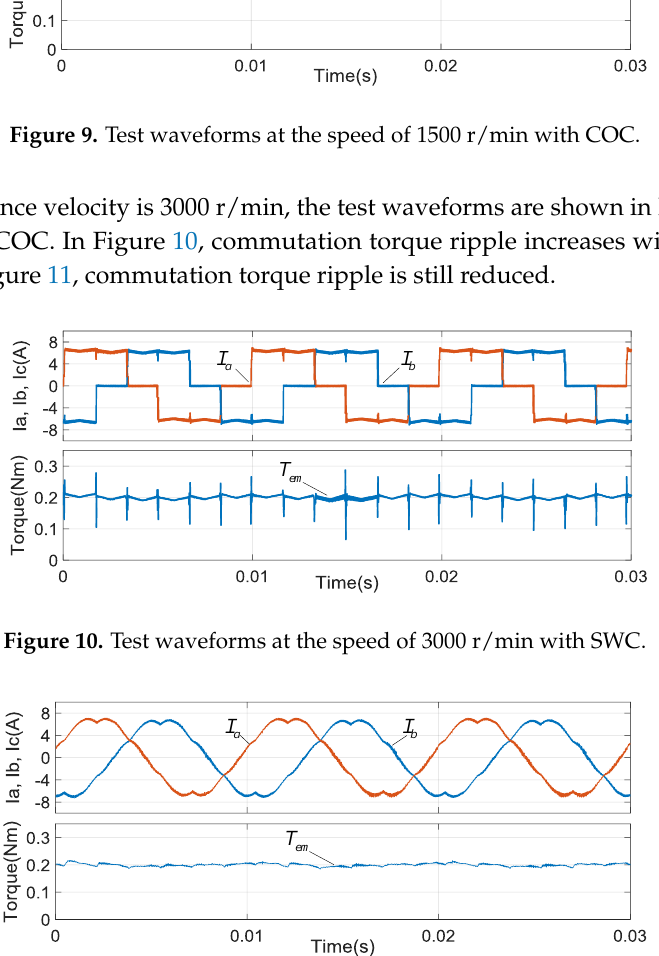
Figure 9. Test waveforms at the speed of 1500 r/min with COC.